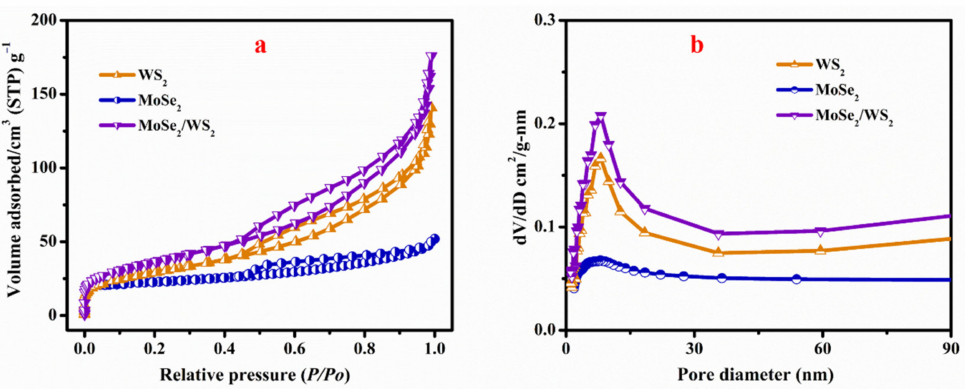
Figure 5. ( a ) BET profiles and ( b ) pore distribution of pristine WS 2 , MoSe 2 , and MoSe 2 -WS 2